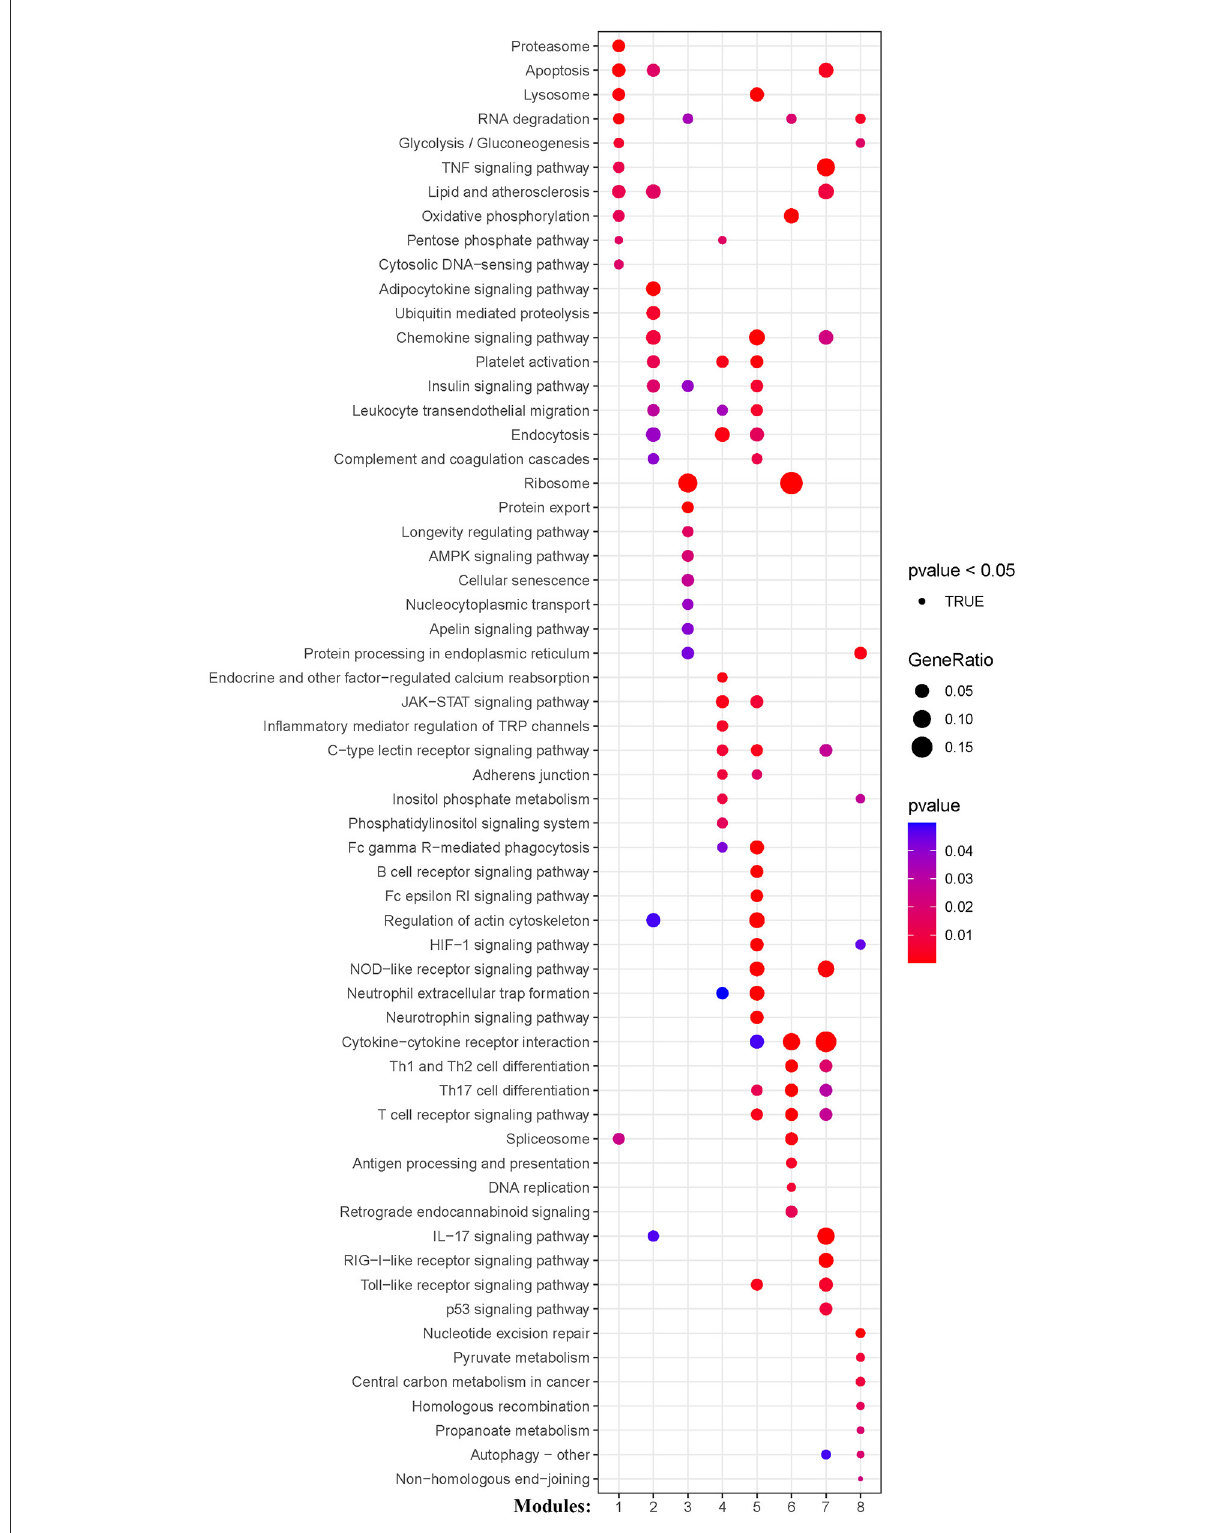
FIGURE7 Module-based pathway analysis. Visualization of pathways identified by the Kyoto Encyclopedia of Genes and Genomes (KEGG)